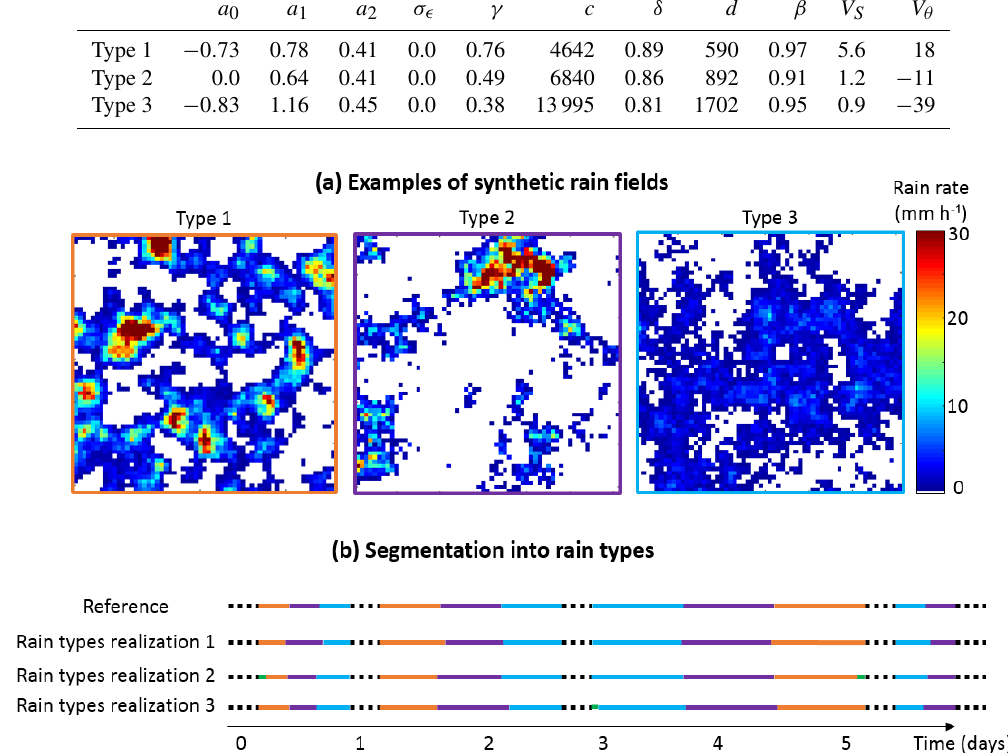
Figure 4. Identification of non-stationarities in rain statistics for a synthetic case study. (a) Examples of synthetic rain fields simulated for each rain type. (b) Segmentation of the time axis into periods with stationary rain statistics. First row: reference. Rows 2–4: segmentation obtained by rain typing applied to synthetic radar-like images. Dotted black lines represent dry